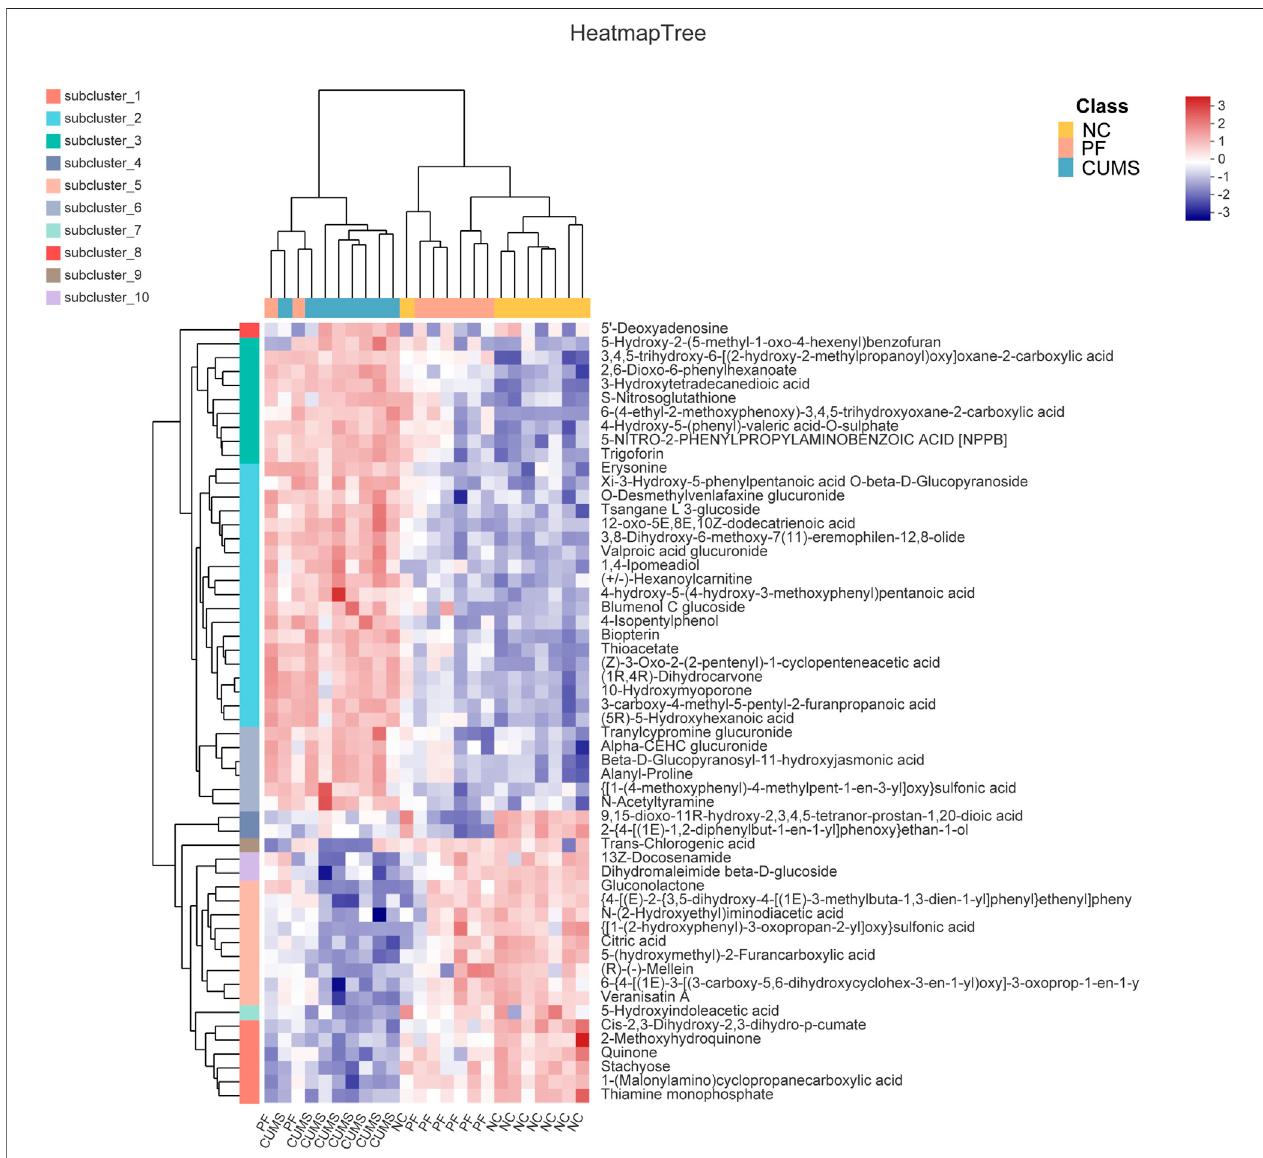
FIGURE 4 | Comparison of differentially expressed metabolite levels between different groups. Each row corresponds to data for a speci fi c metabolite, and each column represents the NC, CUMS, or PF group. Colors indicate the relative expression levels of metabolites in this group of samples.